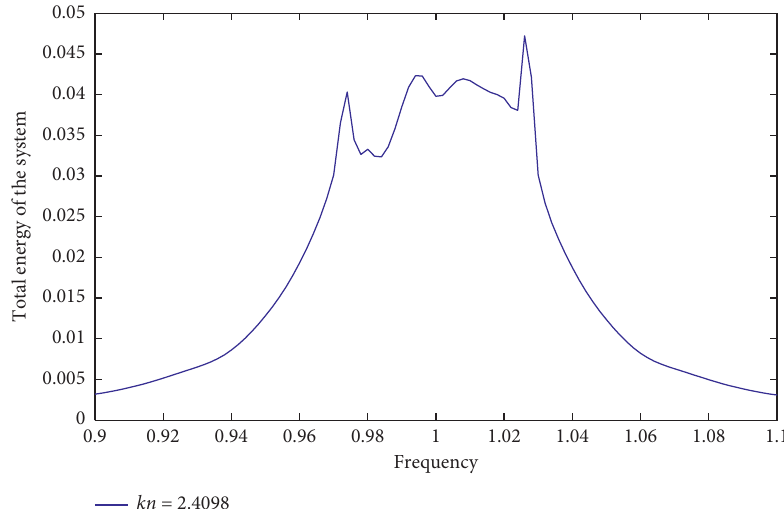
Figure 25: Average total energy of the system with respect to excitation frequency ( kn � kn